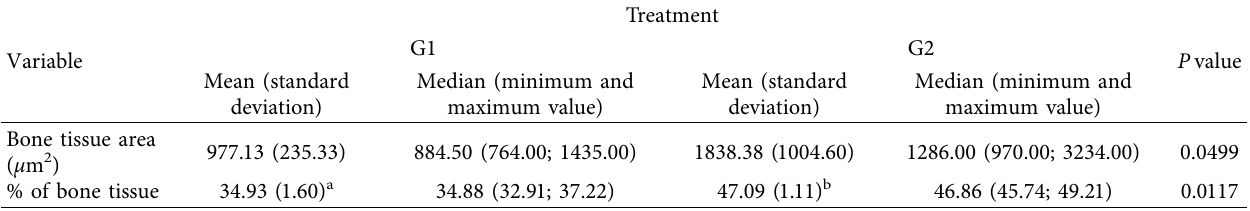
Table 2: Histomorphometric analysis as a function of treatment.